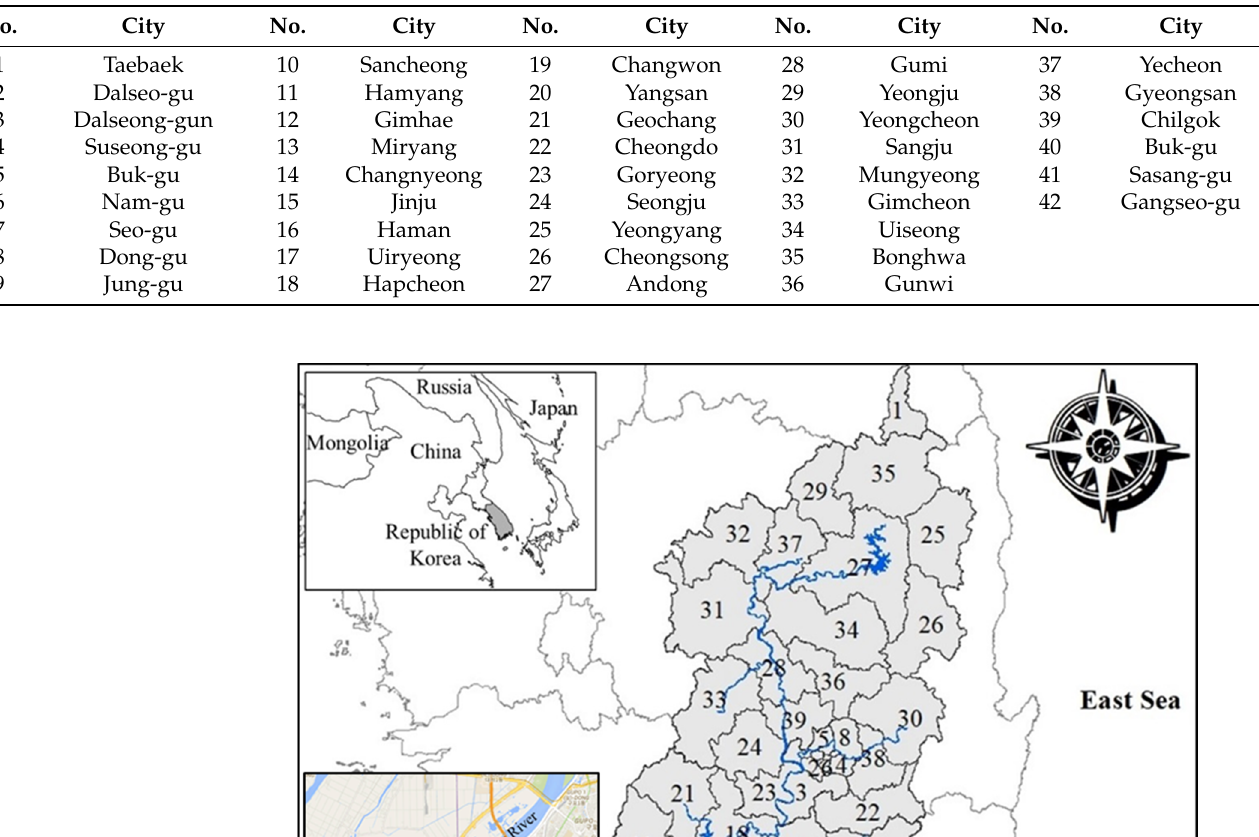
Table 1. Numbers and names of cities on the map of Nakdong River basin.